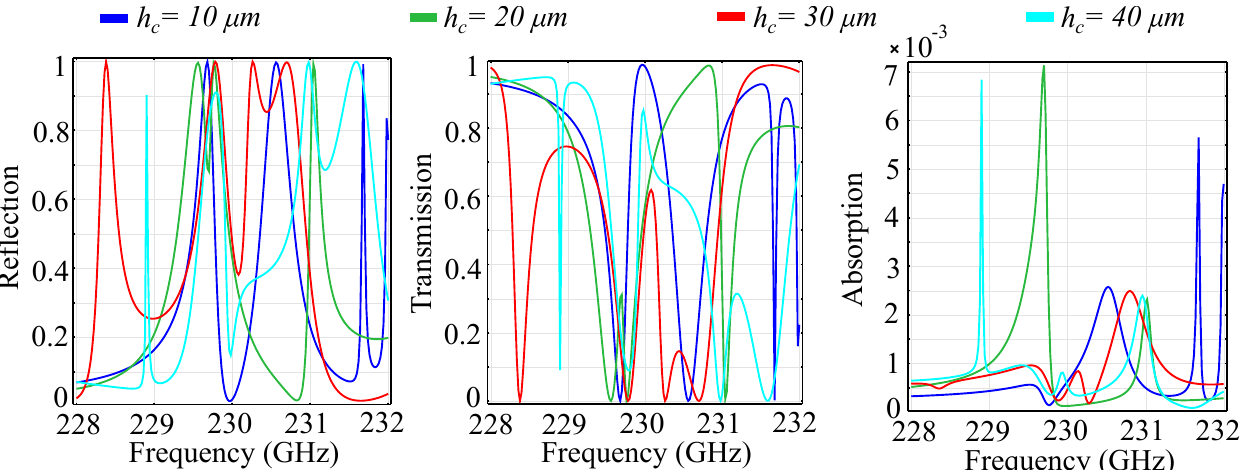
Figure 6. Simulated reflection, transmission, and absorption spectra for fixed ring-cone height ( h c ) values, in the silica glass substrate unit cell configuration.